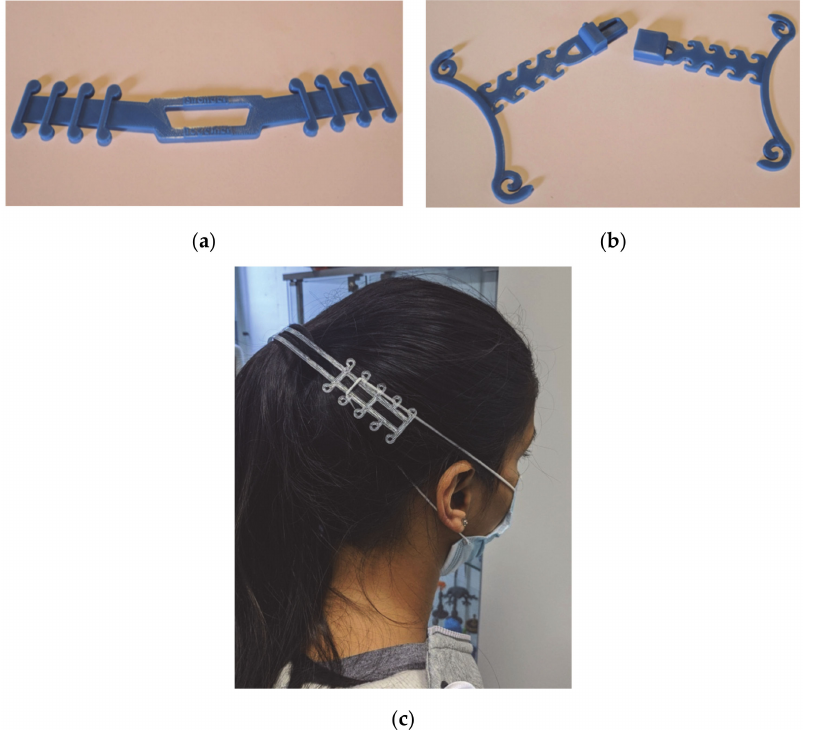
Figure 4. Surgical mask straps; simple, ( a ) fast printing model, ( b ) complex quick-release model top, ( c ) in